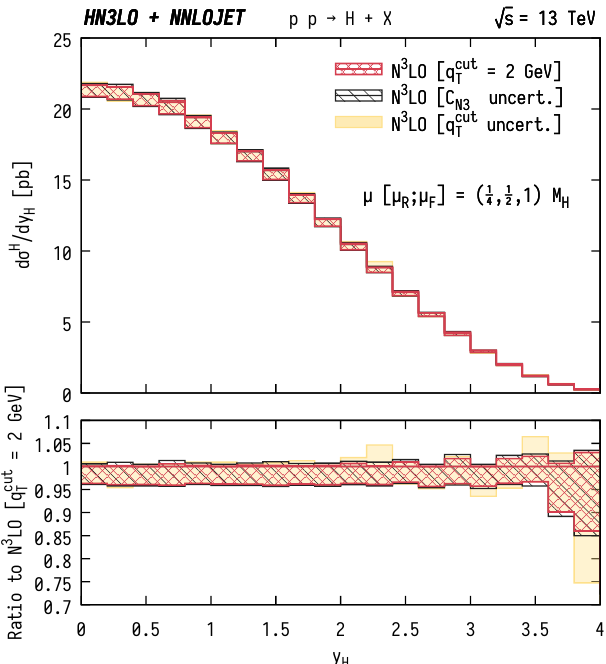
Figure 5 . Rapidity distribution of the Higgs boson as computed using the q T subtraction formalism at N 3 LO. All bands include the seven-point scale variation as detailed in table 1. The red band constitutes our result with q cut = 2 GeV using the central value for the C N 3 coe(cid:14)cient ( C N 3 = T (cid:0) 943). The pale yellow band is obtained as the envelope between the prediction at q cut = 1 GeV T and 2 GeV using C N 3 = (cid:0) 943. The black band is computed at (cid:12)xed q cut = 2 GeV taking the T two extremal values of the C N 3 coe(cid:14)cient according to the uncertainty ( C N 3 = (cid:0) 943 (cid:6) 222), and performing seven-point scale variation as described in the